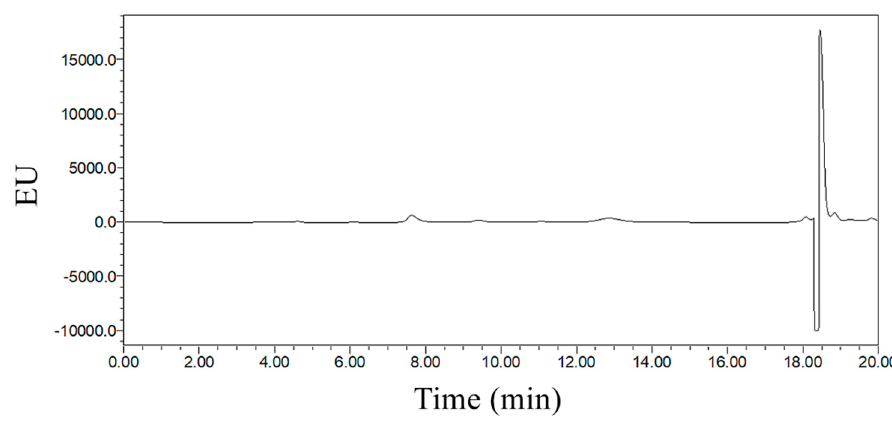
Figure 4. Purification effect of PSA on GLUF-P determination in Jiangxi red soil samples.